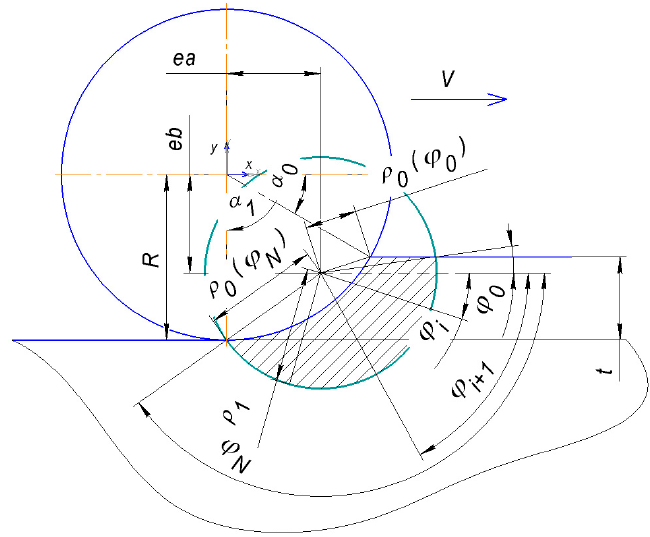
Figure 3. Forming velocity field during wide burnishing.